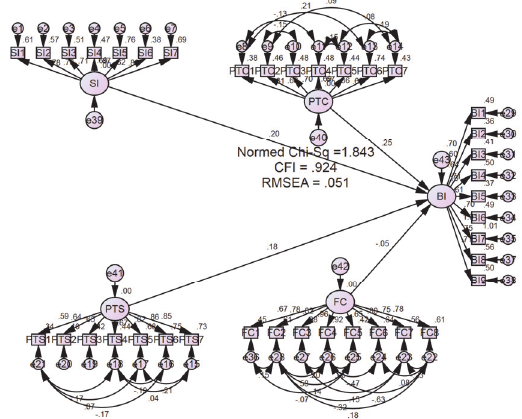
Fig. 3. Confirmatory factor analysis (CFA) of overall Structural